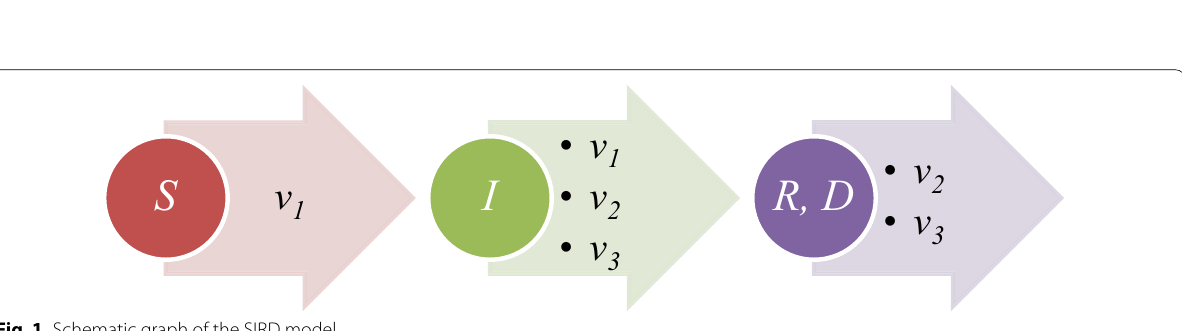
Fig. 1 Schematic graph of the SIRD